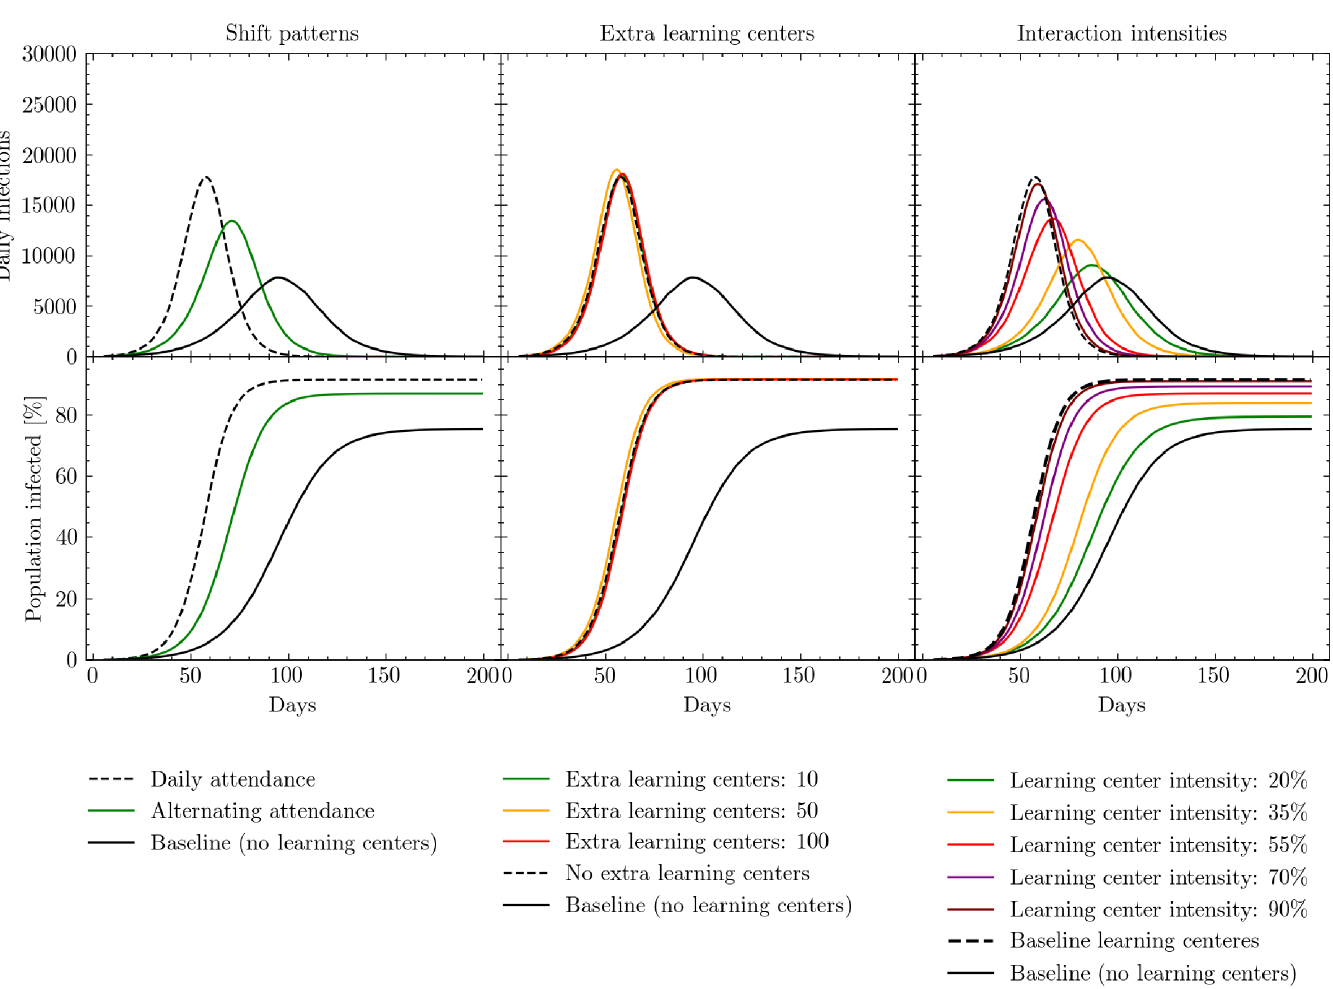
Fig 9. Simulated daily (7-day rolling average) and cumulative infections measured in days since the beginning of the simulation. Black solid lines represent the baseline policy in which learning centers are closed. Black dashed lines represent the policy in which learning centers are open with no additional mitigation strategies. Results show the effects of opening learning centers under three conditions: adjusting the regularity with which children attend learning centers (left); opening additional learning centers (middle); reducing interaction intensities in the learning centers through strategies such as physical distancing, masks, and improved ventilation (right). Note that in the middle panel, the green line overlaps almost precisely with the baseline. See S1 Table for a presentation of the cumulative number of infections, peak intensity and peak timings for these